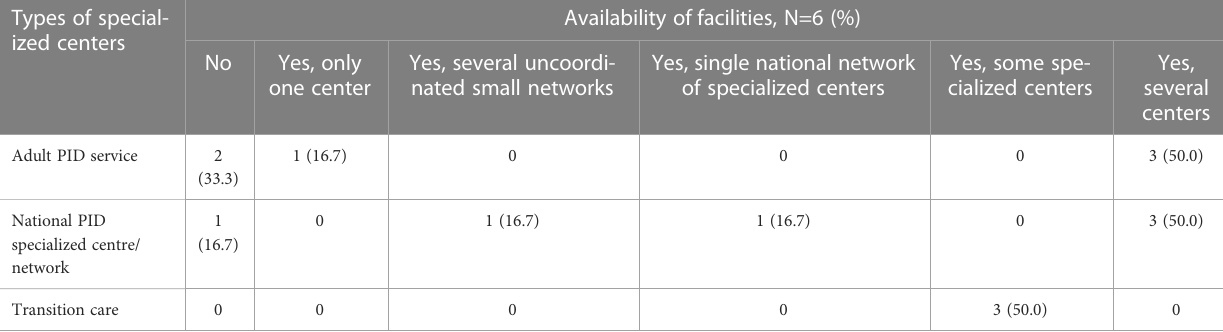
TABLE 3 Availability of specialized centers for Primary Immunode fi ciencies (PID) patients. Types of special- ized centers